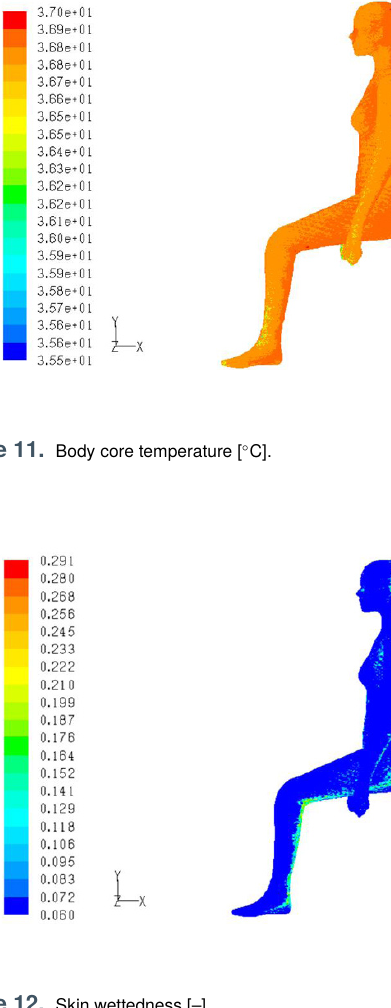
Figure 10. Skin temperature distribution over the body surface [ ◦ C].